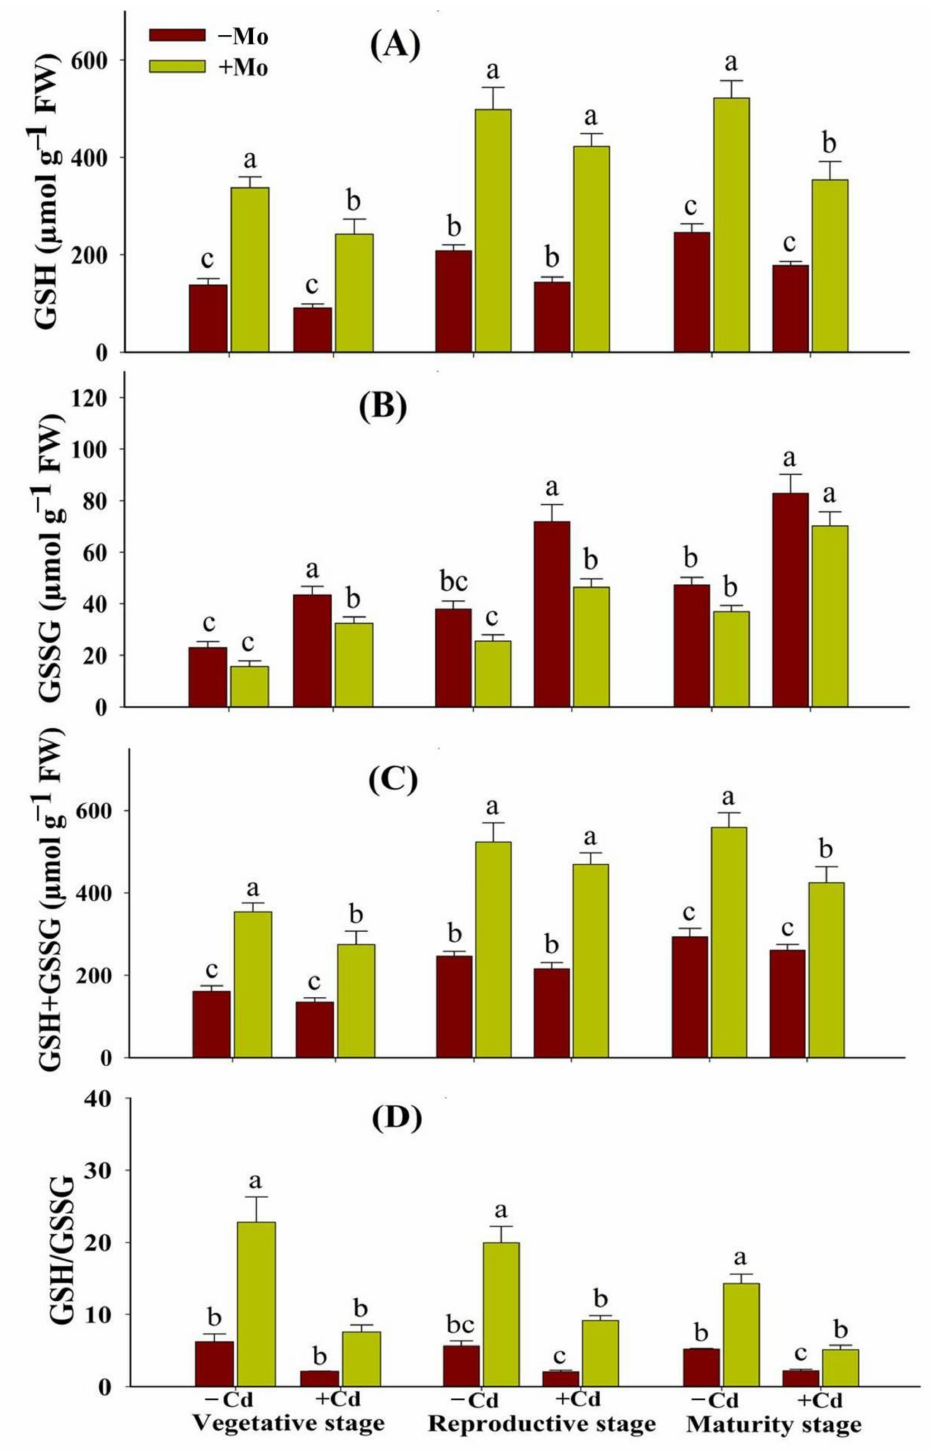
Figure 7. Effect of Mo supply and Cd toxicity on reduced glutathione (GSH) ( A ); oxidized glutathione (GSSG) ( B ); total glutathione (GSSG + GSH) ( C ); and ratio of GSH/GSSG ( D ), in the leaves of aromatic rice ‘Xiangyaxiangzhan’ cultivar, at the vegetative, reproductive, and maturity stages. Bars above means indicate ± S.E. of four independent replicates ( n = 4) and different small alphabetical letters above means reveal significant differences among treatments within a particular growth stage according to the LSD test ( p <